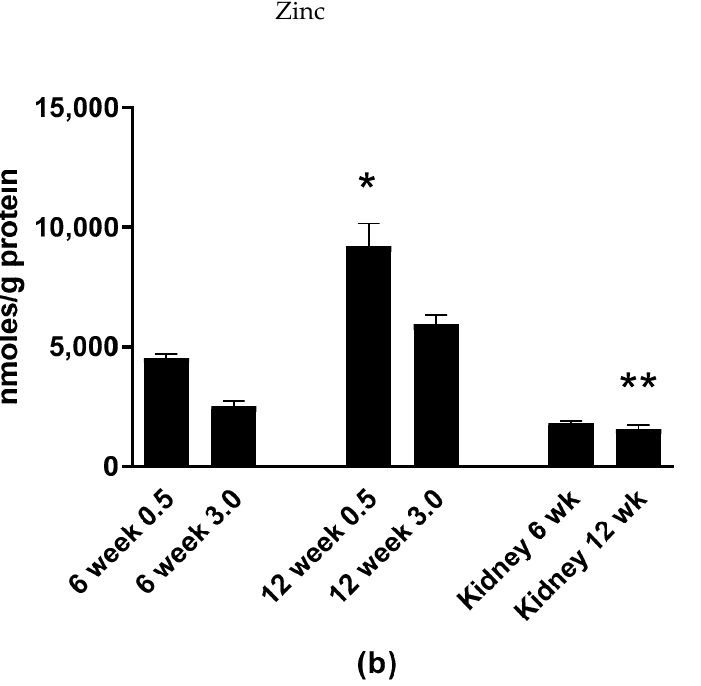
Figure 6. Data show Cd ( a ) or Zn ( b ) accumulation within isolated islets and renal cortex from animals treated with Cd (0.6 mg/kg/day) for 6 or 12 weeks. Islets were incubated in either low “0.5” or high “3.0” glucose; values are glucose concentrations in mg/mL. For both Cd ( a ) and Zn ( b ) asterisk (*) indicates statistically significant differences as compared to the 12 week 3.0 mg/mL glucose islet treatment group (ANOVA followed by Tukey’s multiple comparison test, p ≤ 0.05). Double asterisks (**) indicate significant differences as compared to islet lysates isolated from 12 week Cd treated animals and incubated in 0.5 mg/mL glucose; n ≥ 3 for each treatment group. For zinc ( b ) data set only, other statistically significant differences detected were between treatment groups were: 12 week (0.5) control vs. 12 week (0.5) Cd treated; six week (0.5) Cd treated vs. 12 week (0.5) Cd treated and six week (3.0) Cd treated vs. 12 week (3.0) Cd treated. n ≥ 3 for each treatment group.